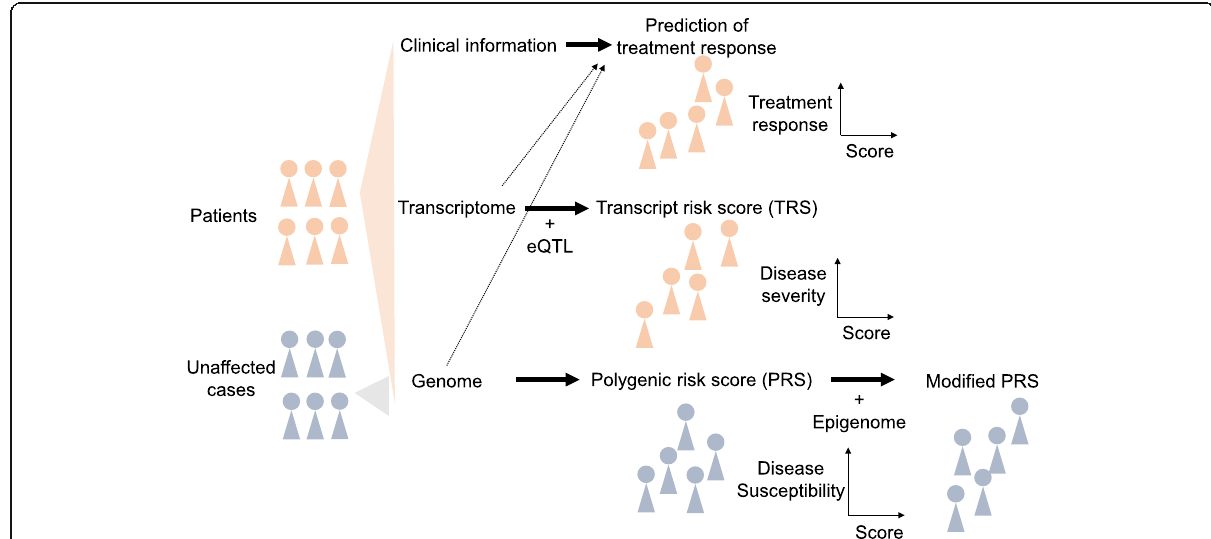
Fig. 1 Present strategies for stratification of disease-affected and unaffected cases. How clinical information, transcriptome, and genome data can be used for predicting clinical outcomes or disease